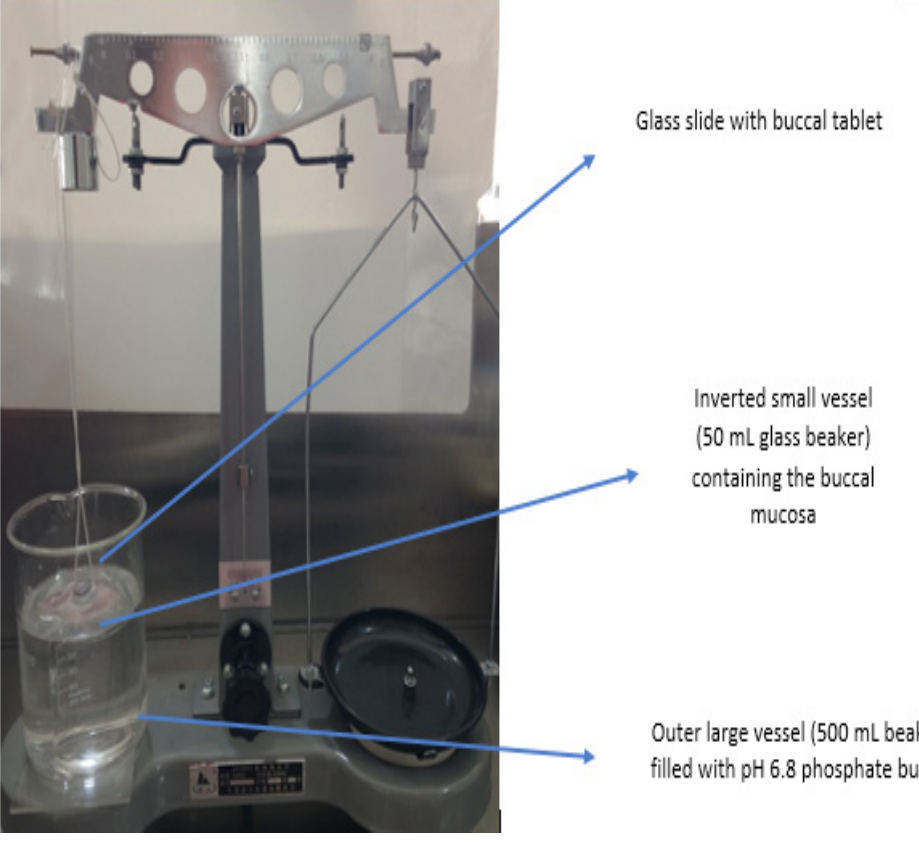
FIGURE 1 - Modified physical balance for mucoadhesive studies.